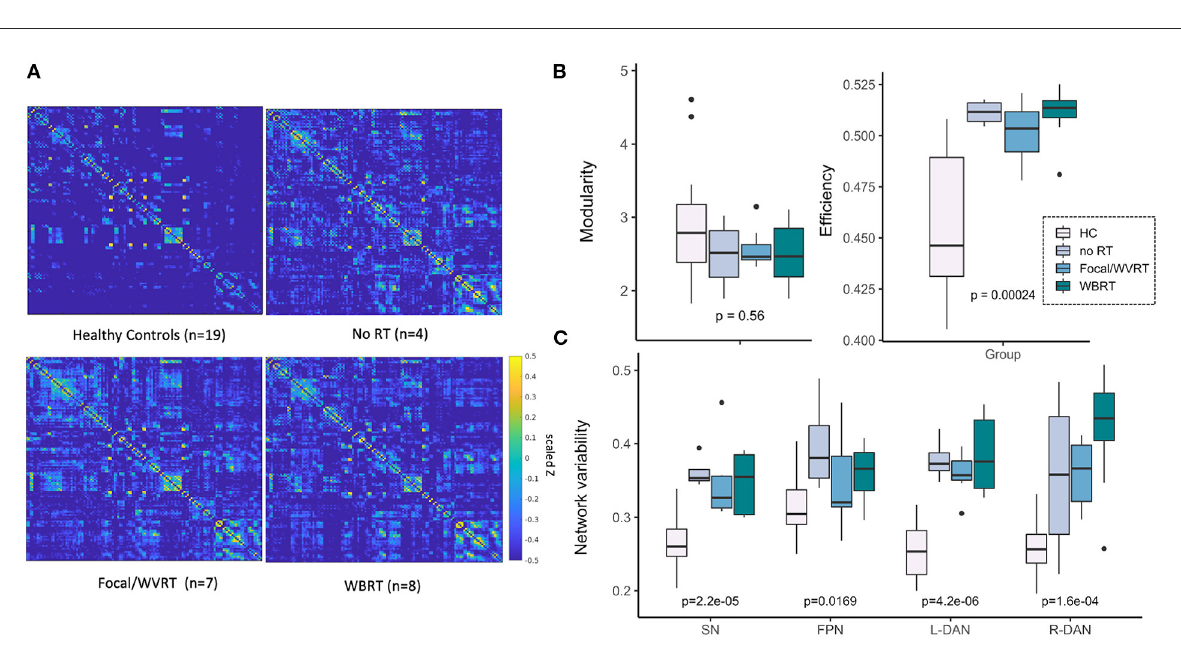
global connectivity differences (Figure 4A). Compared